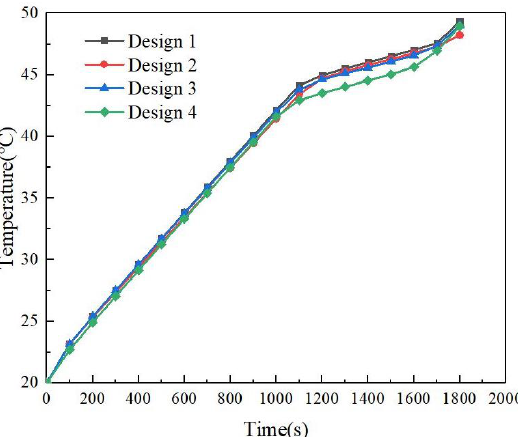
Figure 8. Schematic diagram of different cold plate flow layouts.